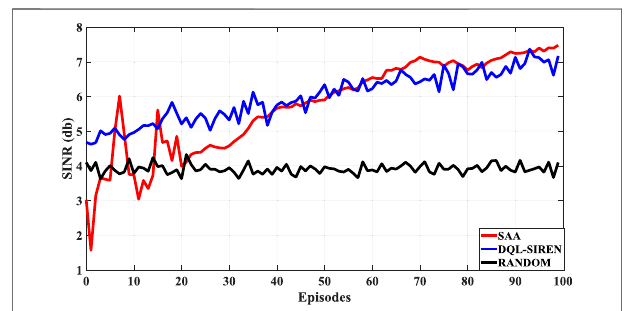
FIGURE 4 | Comparison of the SAA, the DQL-SIREN and the Random